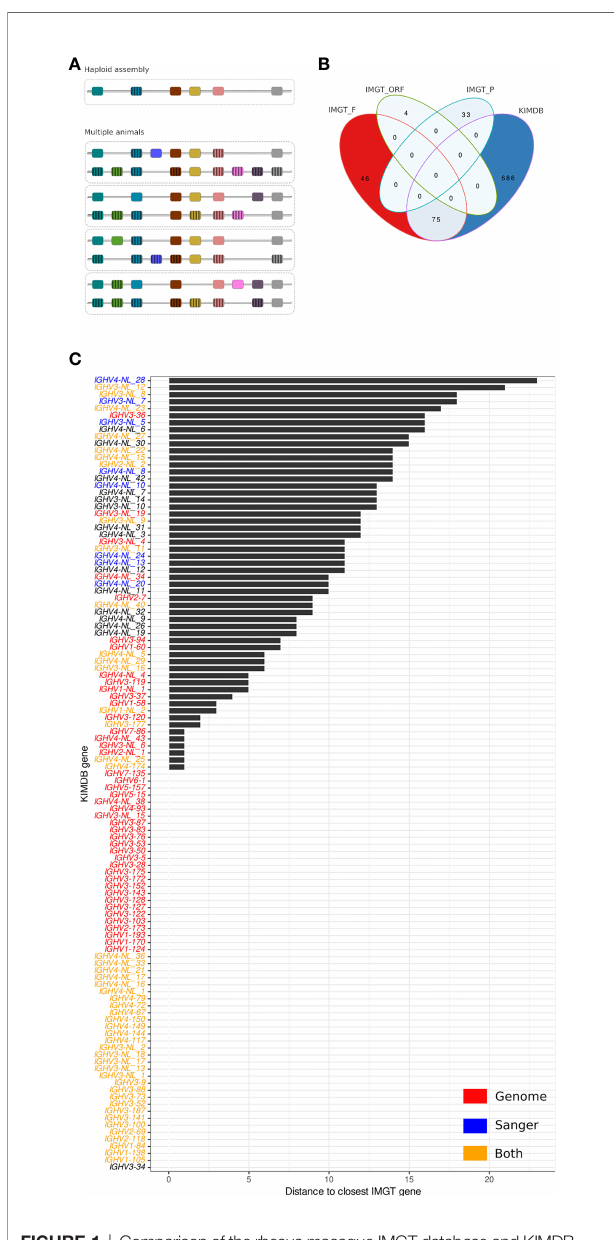
FIGURE 1 | Comparisonof the rhesus macaque IMGT database andKIMDB. (A) Schematic ofreference database approaches. Database construction following expression-based germline inference from multiple animals, where individual structural variations are cross-compensatedbyother animals compared to database constructionfollowing identi fi cationof all genes present ina haploid IGH assemblythat lacks genes due to structural variation. (B) Venndiagram showing exact matches between IMGT/VQuest alleles marked as functional (IMGT_F), open reading frame (IMGT_ORF) or pseudogenic (IMGT_P) and alleles in the rhesus macaque KIMDB. (C) Distance in nucleotide sequence betweenclosest matching IGHV alleles oftwo genes from the rhesus macaque IMGT database and KIMDB. Genes that have at least one allele less than6 nucleotidedifferences across the entire querysequence were assumedpresent in public genome assemblies and are labeledinred,IGHV sequences that were Sanger sequence-validated in VazquezBernat et al.are labeled inblue, and IGHV sequences that were both present in public genome assemblies andSanger-validated are labeled in orange. The remaining genes are